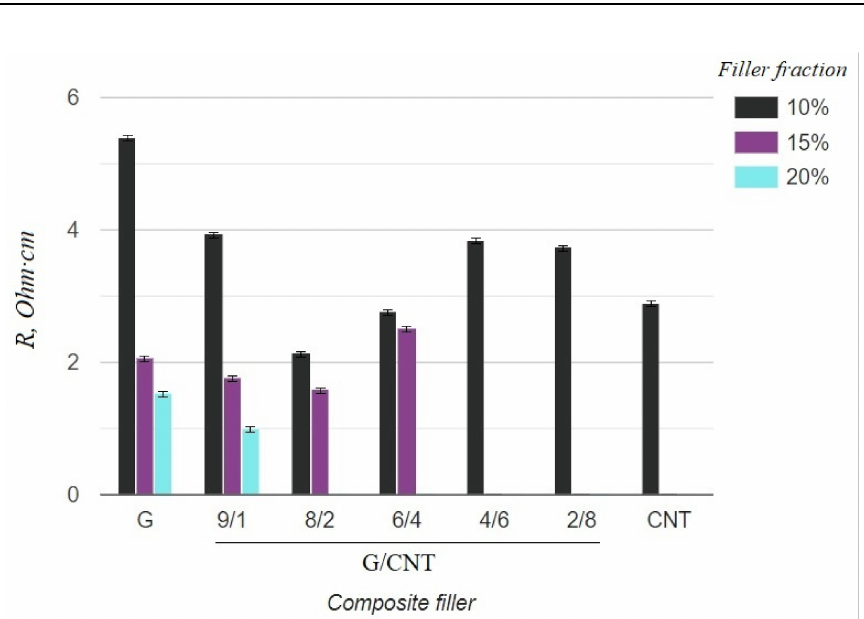
Figure 3. Resistivity of silicone composites with different filler